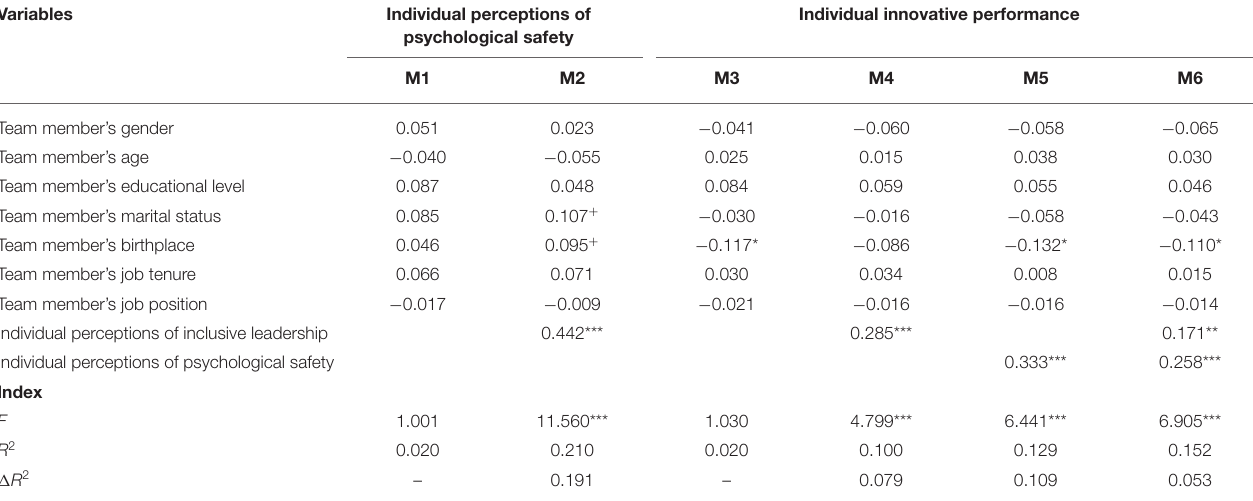
TABLE 5 | Results of hypotheses testing at the individual level. Variables Individual perceptions of psychological safety